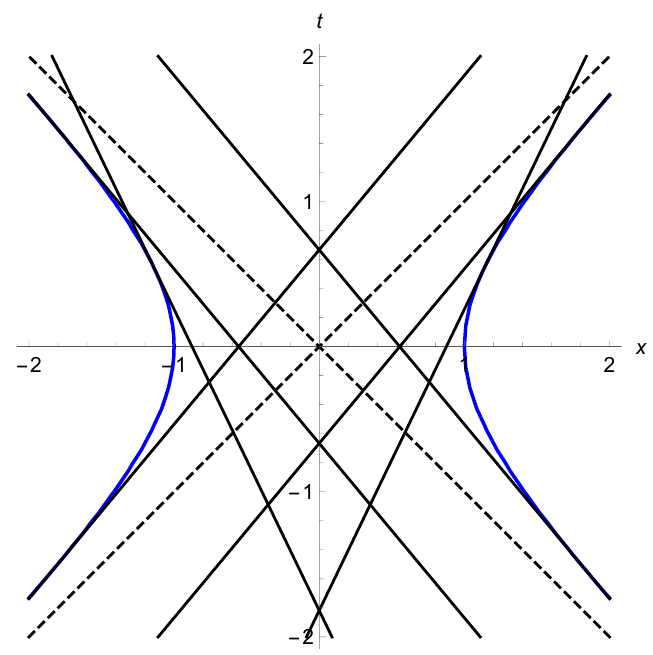
Figure 1 . Few sample light rays (solid black lines) in the worldsheet (2.5). Here x and t are in unit of b . The hyperbolic curves (blue) are trajectories of quark and anti-quark. Two quarks are causally disconnected with the horizons at t = ± x (dash